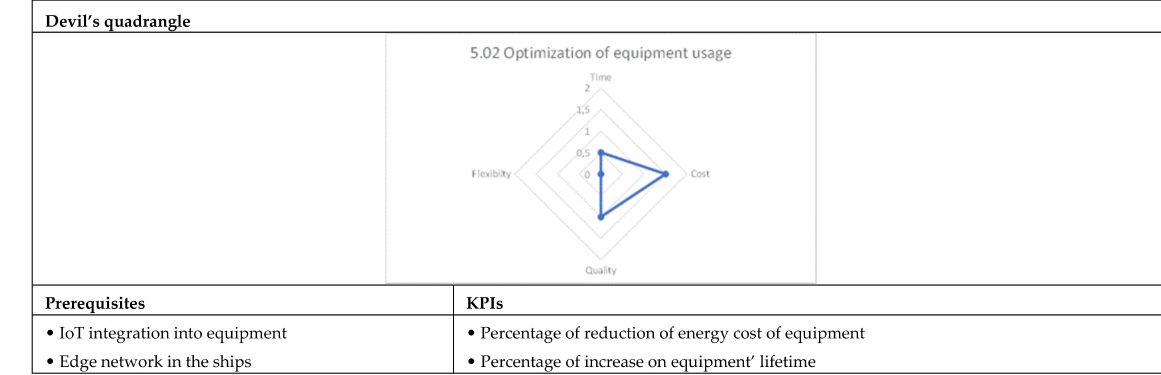
Figure A37. Optimization of equipment data sheet.